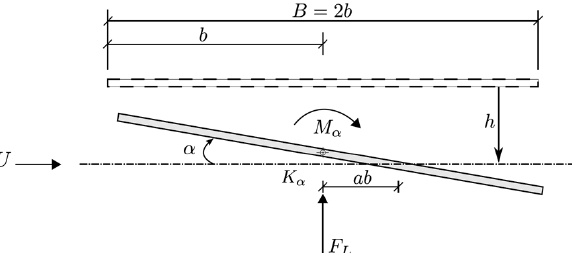
Figure 1. Definition of degrees-of-freedom (heave h and pitch) and aeroelastic forces (lift, F L , and moment, M ) for flutter analysis of flat plate [31].